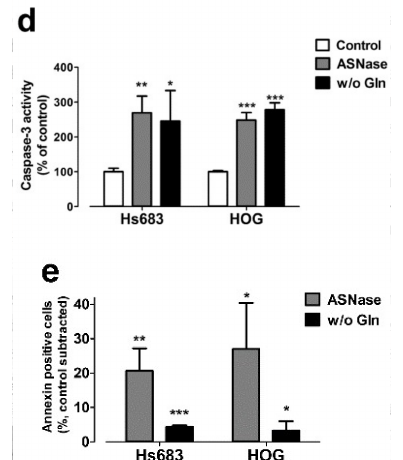
Figure 2. Gln starvation kills oligodendroglioma cells. ( a ) Viability of Hs683 and HOG cells incubated with increasing concentrations of Gln (0.03, 0.125, 0.25, 0.4, 0.7, 1.25, 2 and 4 mM) for 48 h. Data are expressed as % of control (4 mM Gln). Means ± SD of three experiments, with three independent determinations each, are shown. Dose response curves were evaluated by non-linear regression analysis. ( b ) Viability of Hs683 and HOG cells incubated in the presence (+) or in the absence ( − ) of Gln (4 mM), or MSO (1 mM) for 48 h. Data are expressed as % of control (cells maintained at 4 mM Gln). Means ± SD of three experiments, with three independent determinations each, are shown. *** p < 0.001 vs. control, ns, not significant, as assessed with a two-tail Student t test for unpaired data. ( c ) Viability of Hs683 and HOG cells incubated with increasing concentrations of L-asparaginase (0.003, 0.01, 0.03, 0.1, 0.3, and 1 U/mL) for 48 h. Data are expressed as % of control (untreated cells). Means ± SD of three experiments, with three independent determinations each, are shown. Dose response curves were evaluated by non-linear regression analysis. ( d ) Caspase-3 activity was assessed in Hs683 and HOG cells treated for 36 h in the presence (Control) or in the absence ( w / o Gln) of Gln (4 mM) or in the presence of L-asparaginase (ASNase, 1 U/mL). ( e ) Annexin V positive population was evaluated in Hs683 and HOG cells treated for 24 h as described in panel c. The graph shows the mean % plus SD ( n = 3) of Annexin V positive cells for each condition after the subtraction of the value obtained in control. For ( c , d ), data represent means ± SD of two experiments with two independent determinations each. * p < 0.05, ** p < 0.01, *** p < 0.001, as assessed with a two-tail Student t test for unpaired